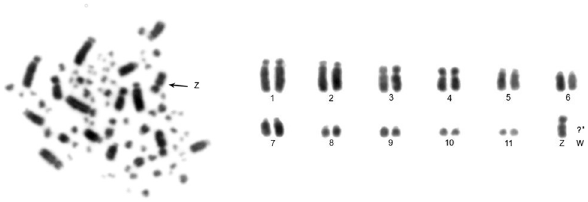
Figure 1 - Metaphase and partial karyotype of a female specimen of Conopophaga lineata. *It was not possible to identify the W sex chromo-